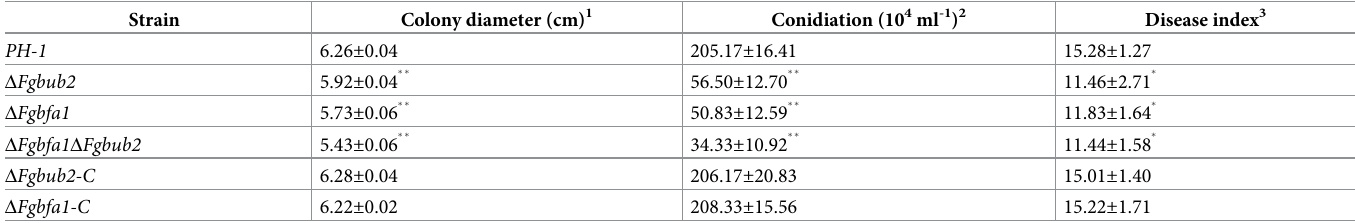
Table 2. Phenotypic characterization of FgBUB2 and FgBFA1 deletion